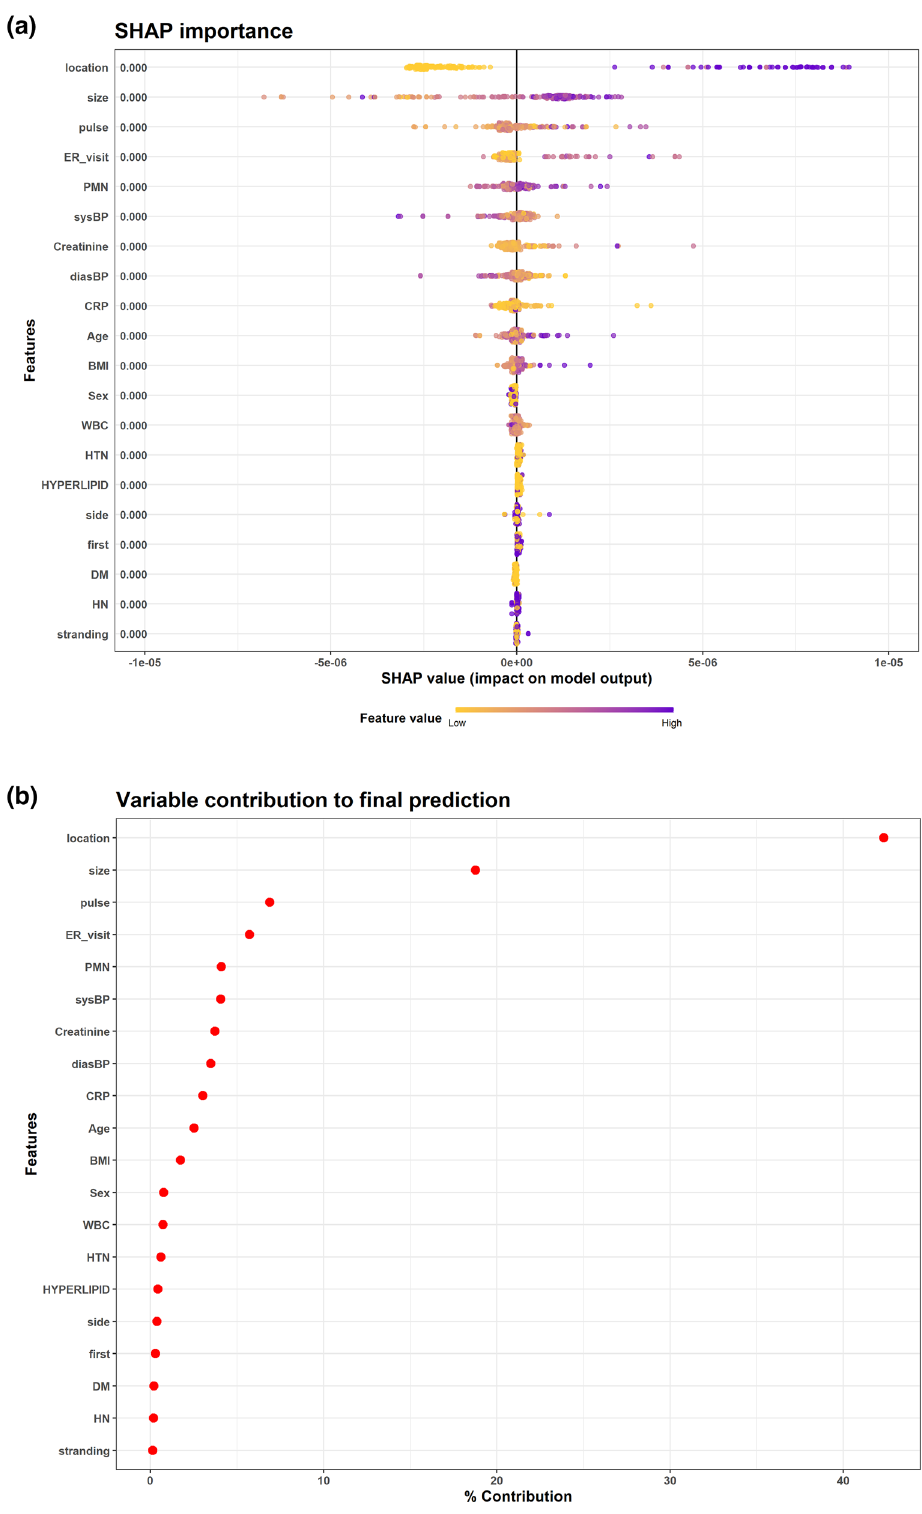
Figure 2. Feature importance of the XG model. ( a ) SHAP values. Each dot represents a patient measurement. The figure depicts the change in prediction probability when changing a feature value. Wider range depicts higher impact on the prediction. ( b ) Mean feature importance. Each dot represents the features contribution to the final prediction of the model. Higher contribution represents more impact on the final